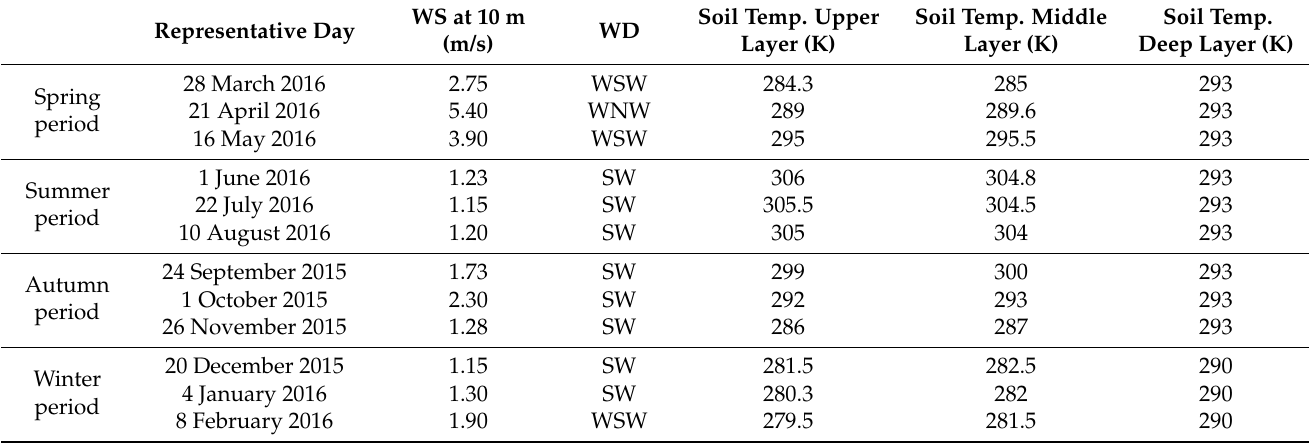
Table A1. Input boundary conditions for ENVI-met microclimate